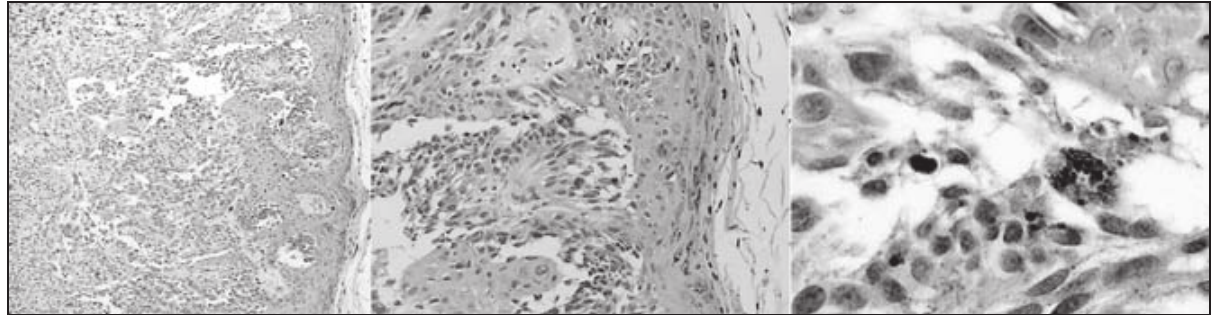
Figura 1 – Melanoma maligno: biópsia excisional (HE 40x, 100x e